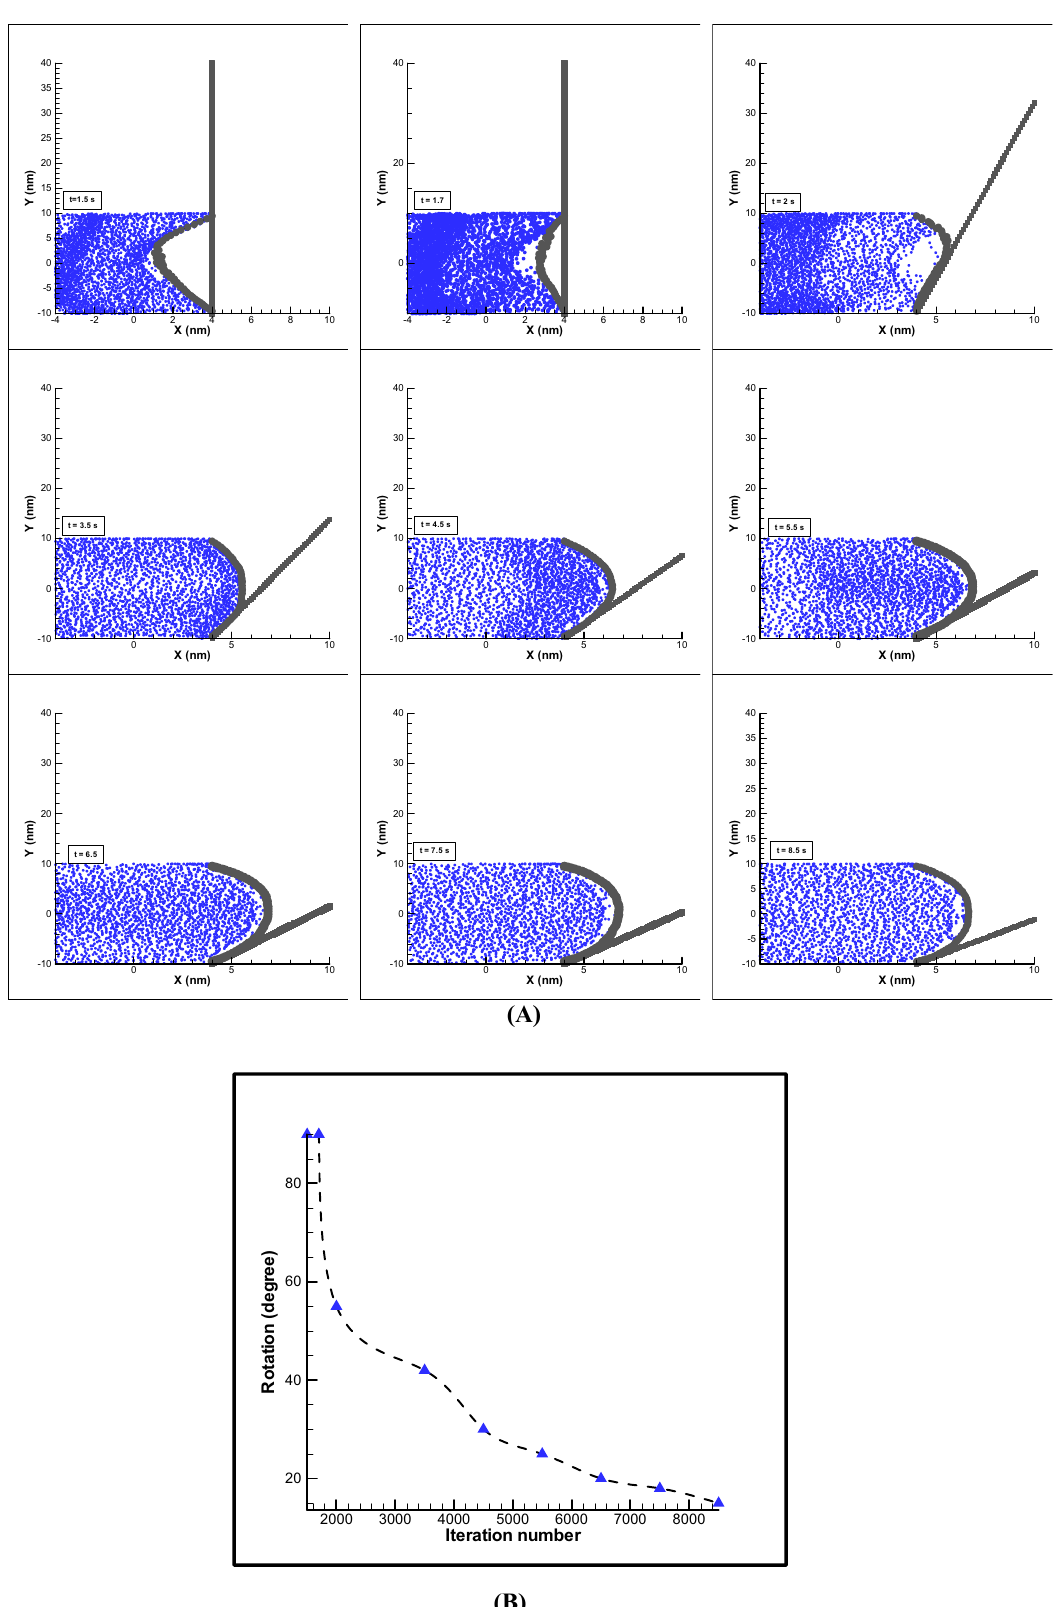
Figure 3. Rotation of stem over time. Displacement of membrane and step due to EOF, kH = 8, E0 = 250 V/m, ψ 0 = − 25 mV ( A ). Angular displacement of stem over iteration numbers ( B